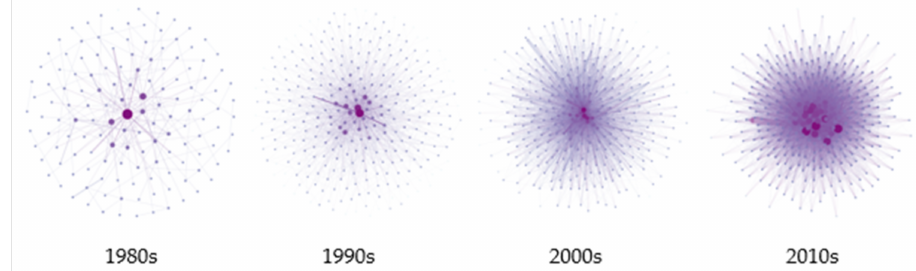
Figure 5. Form of corporate inter-city investment network in the 1980s, 1990s, 2000s, and 2010s. Meanwhile, the results for the overall indicators are in line with expectations (Table 2).